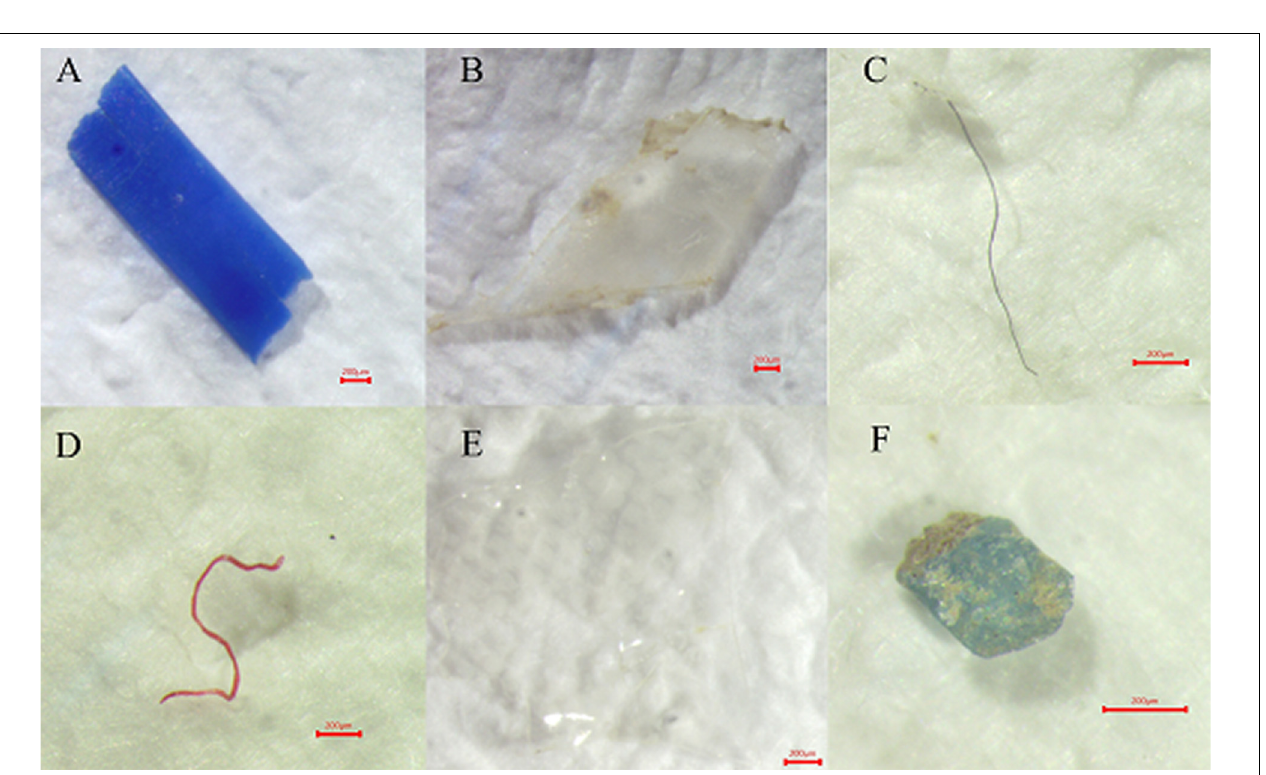
FIGURE 3 | Selected microplastic shapes inspected by SteREO microscope: fragment (A,B) , fiber (C,D) , film (E) , and pellet (F) .